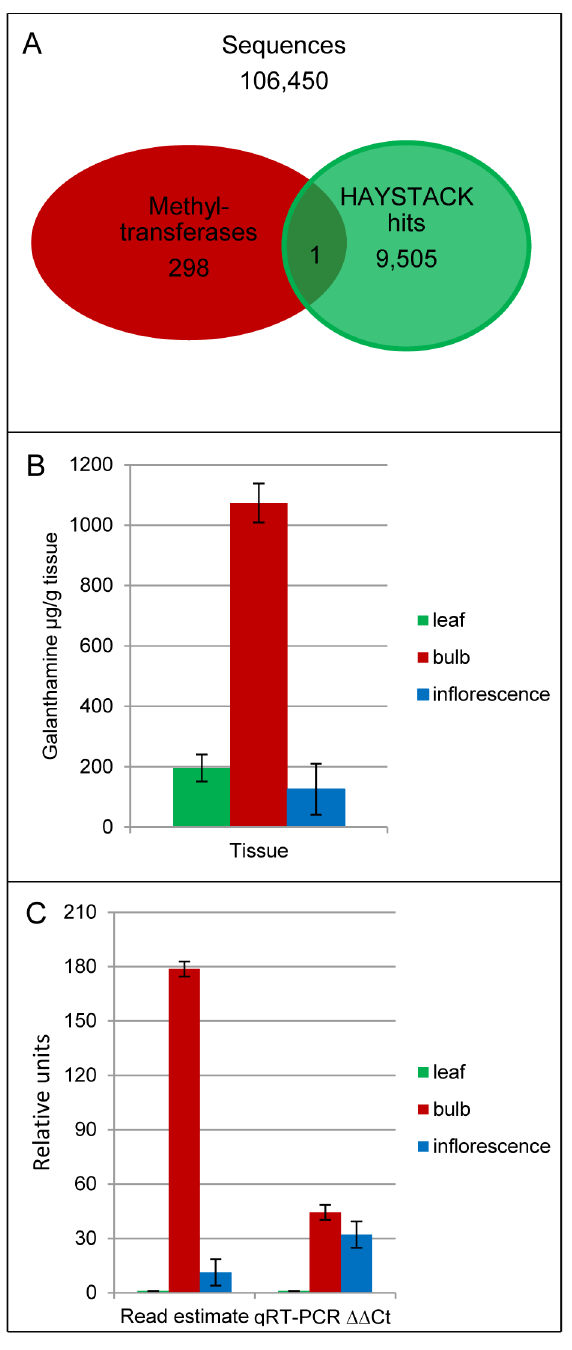
Figure 2. Identification of Np N4OMT in the daffodil transcrip- tome. (A) Venn diagram of all sequences, all OMTs and all galanthamine correlating sequences according to HAYSTACK. (B) Accumulation level of galanthamine in daffodil (C) Candidate Np N4OMT expression profile in leaf, bulb and inflorescence with the relative initial read estimate and qRT-PCR DD Ct on the y-axis with leaf tissue set to 1. doi:10.1371/journal.pone.0103223.g002 O -methylation. HMBC correlations from both the methoxyl protons ( d H 3.88) and H-6 9 ( d H 6.90) to the same carbon ( d C 149.9) placed the methoxyl group at C-4 9 . Its location was further supported by a ROESY correlation from the methoxyl protons to H-5 9 ( d H 6.98). The NMR data thus confirmed that 4 9 - O -